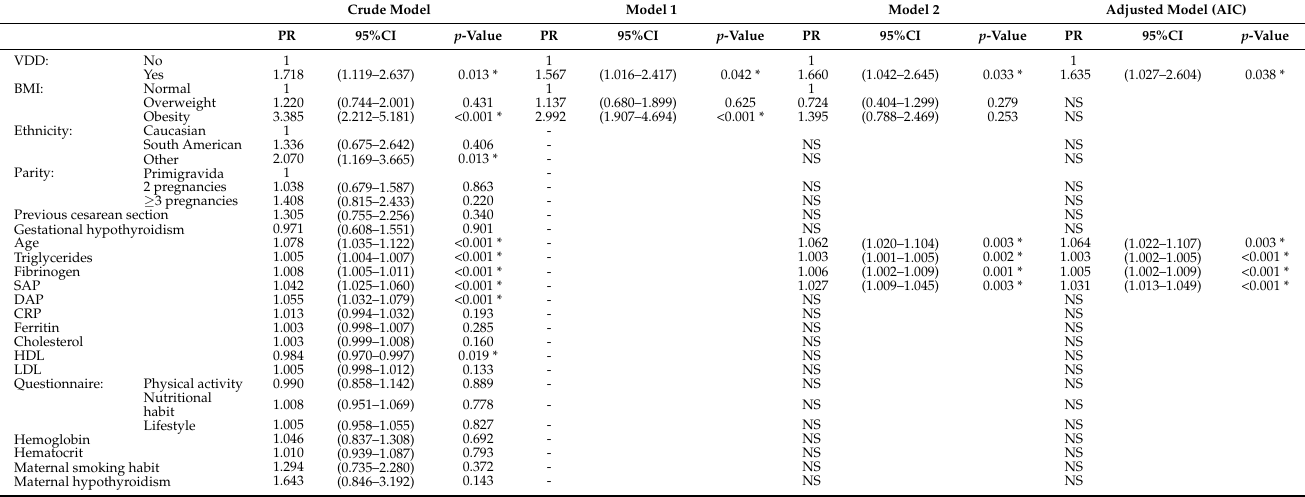
Figure 2. Mean vitamin D serum levels in relation to BMI and grouped by the presence of GDM. Error bars represent the mean and 95% confidence intervals. Table 2. Association study. Prevalence ratio for GDM, estimated by Poisson regression